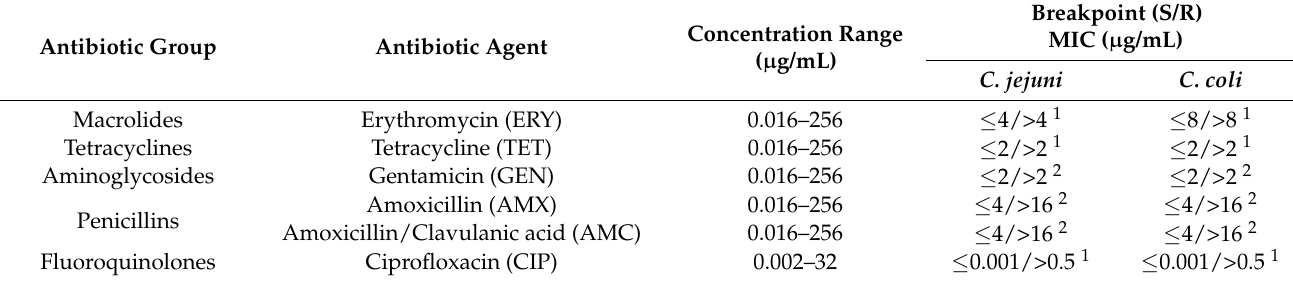
Table 6. Overview of the tested antibacterial agents, antibacterial concentration ranges, and corre- sponding breakpoints for C. jejuni and C. coli